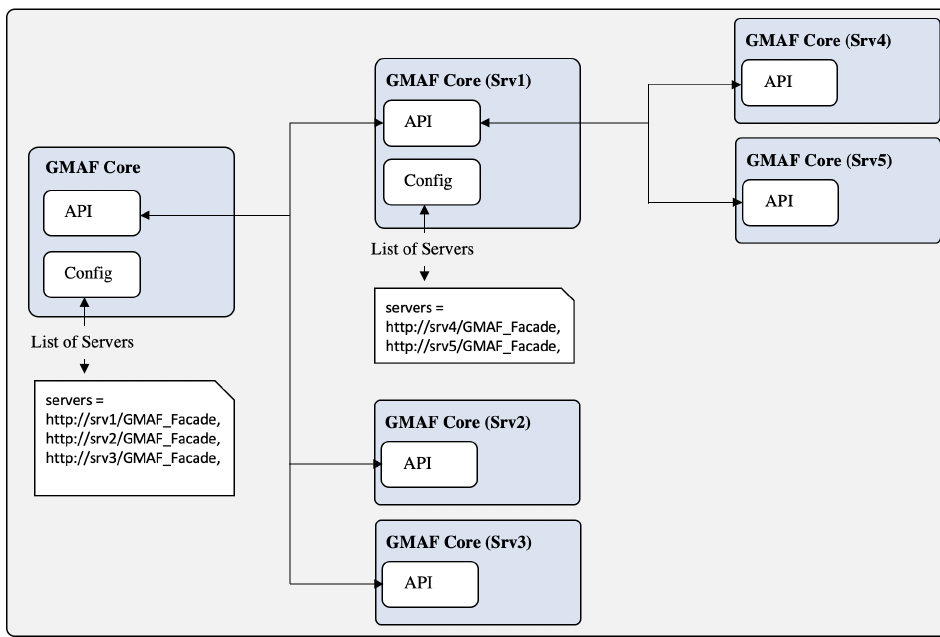
Figure 3. Distributed processing in the